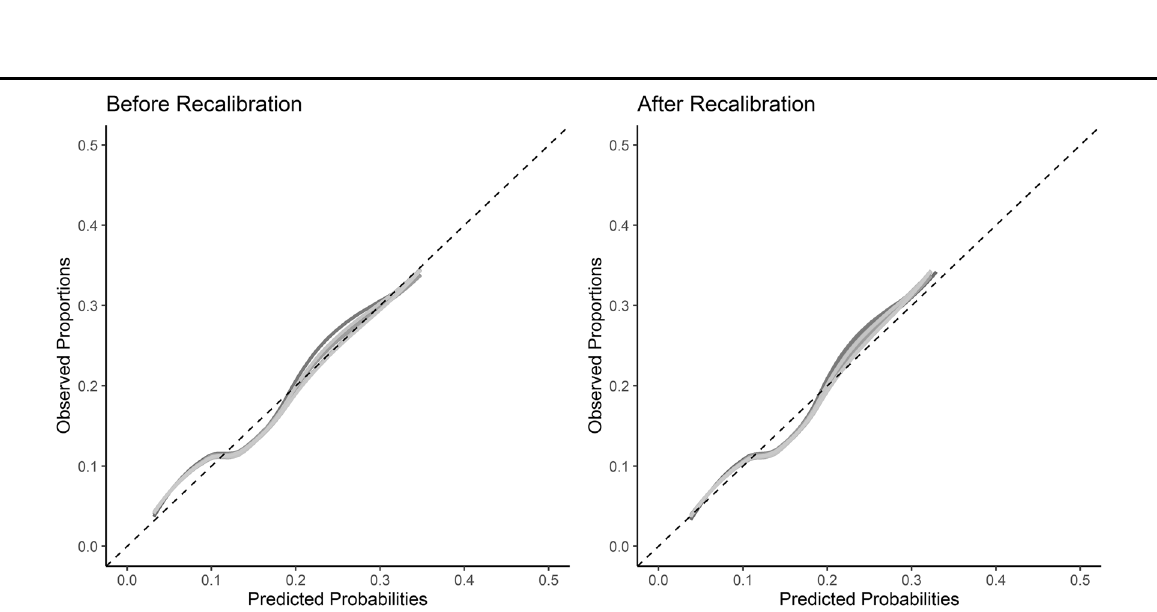
Fig. 2 Calibration plot of the validation dataset before (left) and after (right) recalibration. Fitted lines are the model predicted probabilities categorized into 10 groups for each of the 20 imputed